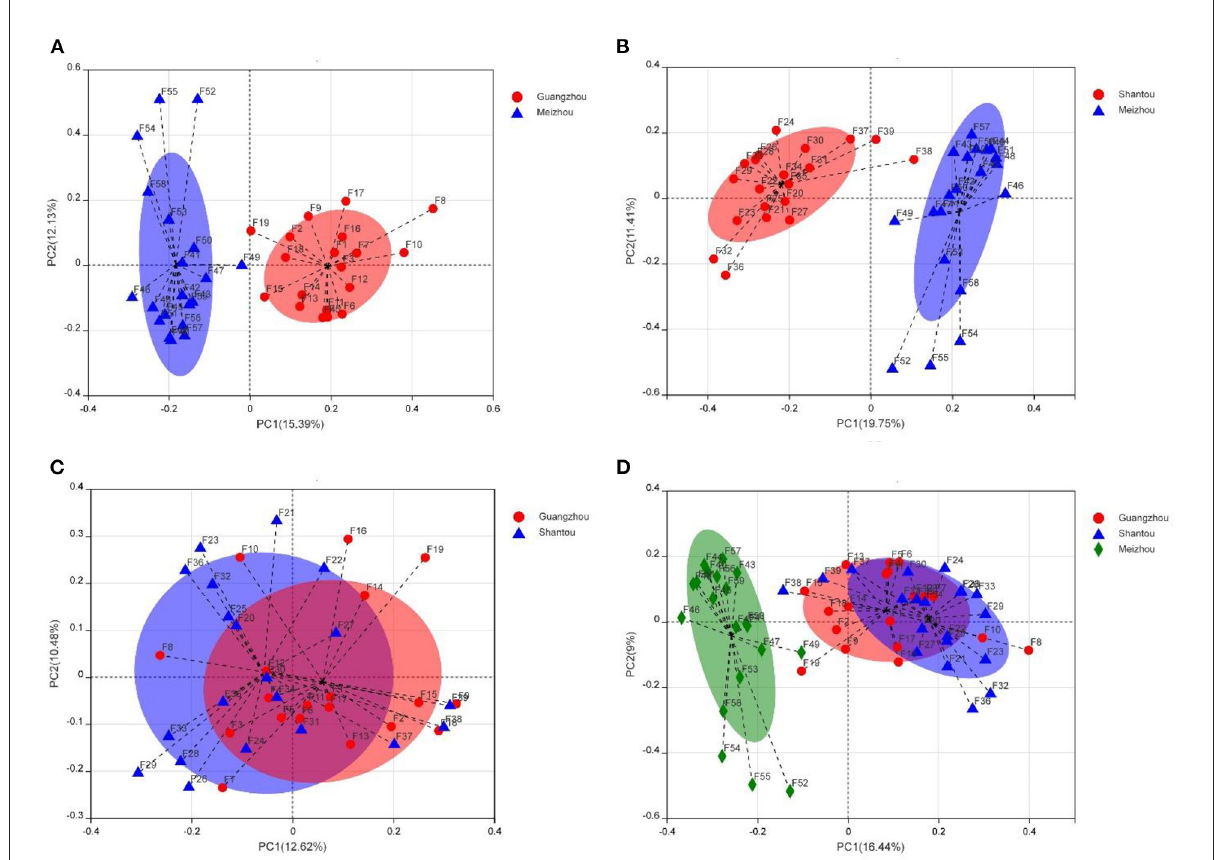
FIGURE4 Taxonomic diversity of microbiomes from samples from Guangzhou, Meizhou, and Shantou. The principal coordinate analysis (PCoA) graph analysis is based on the Bray-Curtis distance at the operational classification unit (OTU) level, and each sample is represented by a point. (A) Guangzhou vs. Meizhou. (B) Shantou vs. Meizhou. (C) Guangzhou vs. Shantou. (D) Guangzhou vs. Shantou vs.